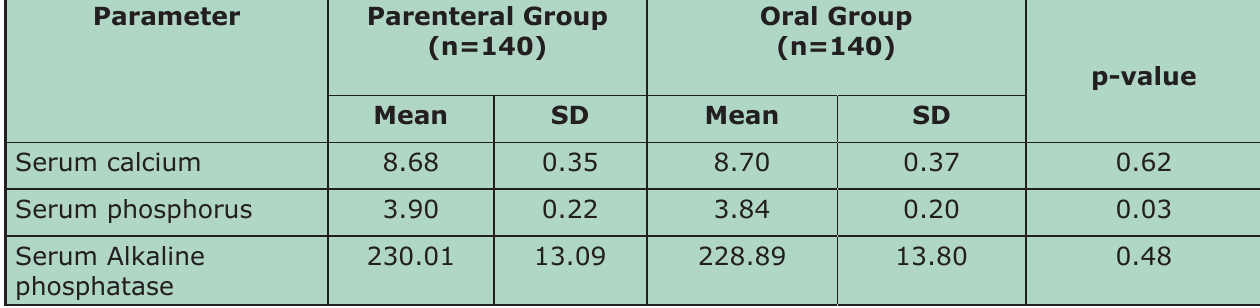
Table-II: Comparison of parental and oral vitamin D supplementation in the treatment of nutritional rickets at baseline